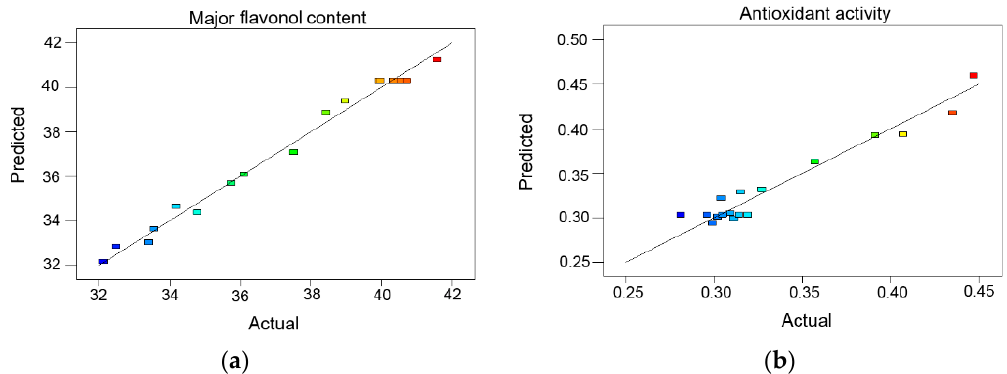
Figure 3. Correlation graph between the predicted and experimental yield values. ( a ) The correlation graph of major flavonol content; ( b ) The correlation graph of antioxidant activity.